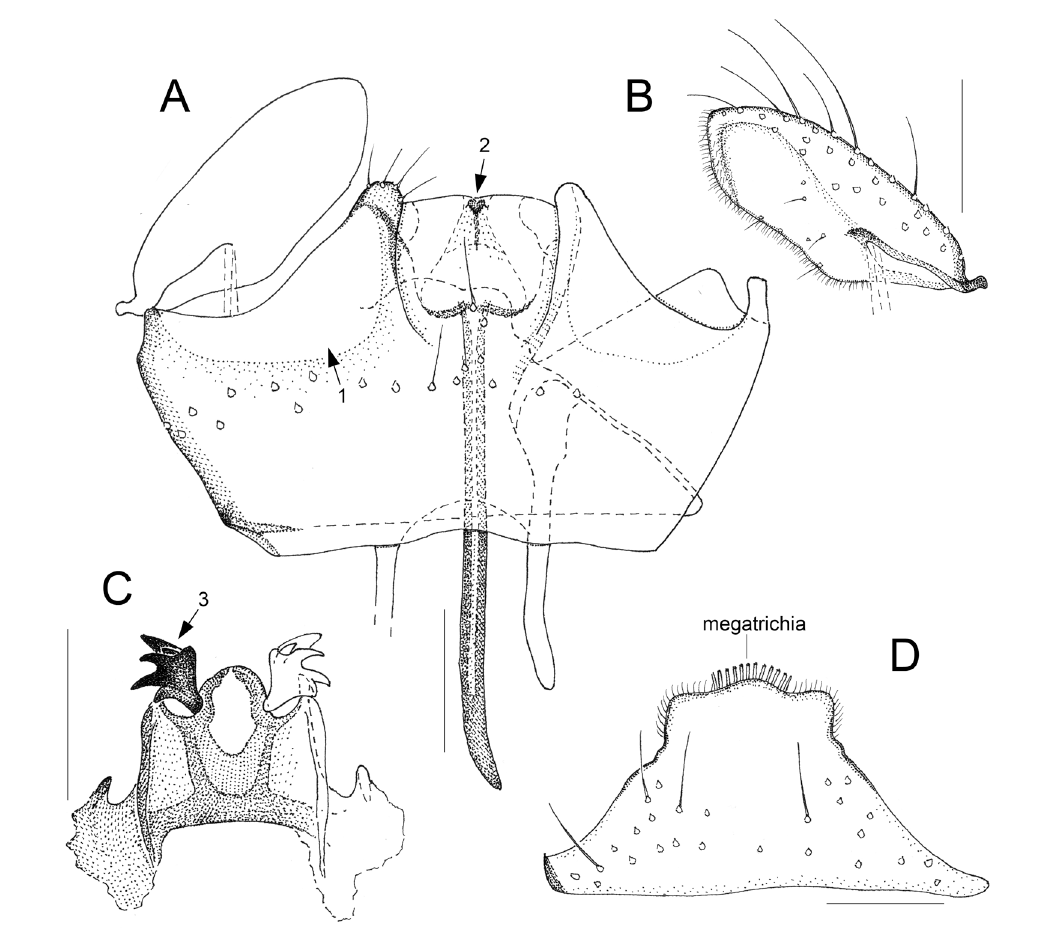
Fig. 6. Glemparon cervus sp. nov., holotype, ♂ (NZAC, no. CEC1414). A . Genitalia, ventral. B . Gonostylus, ventral. C . Tegmen, ventral. D . Ninth tergite, dorsal. Scale bars = 0.05 mm. Numbered arrows indicate diagnostic characters (see